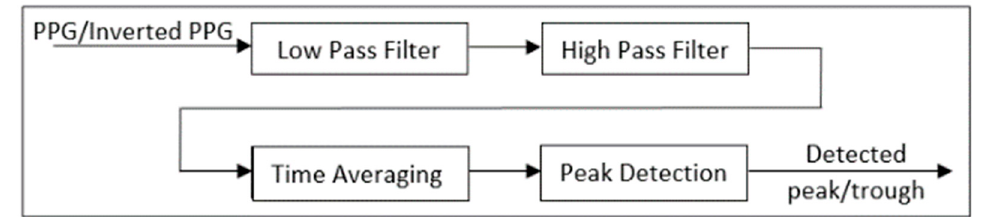
Figure 2. High-level block diagram of the peak/trough detection algorithm.